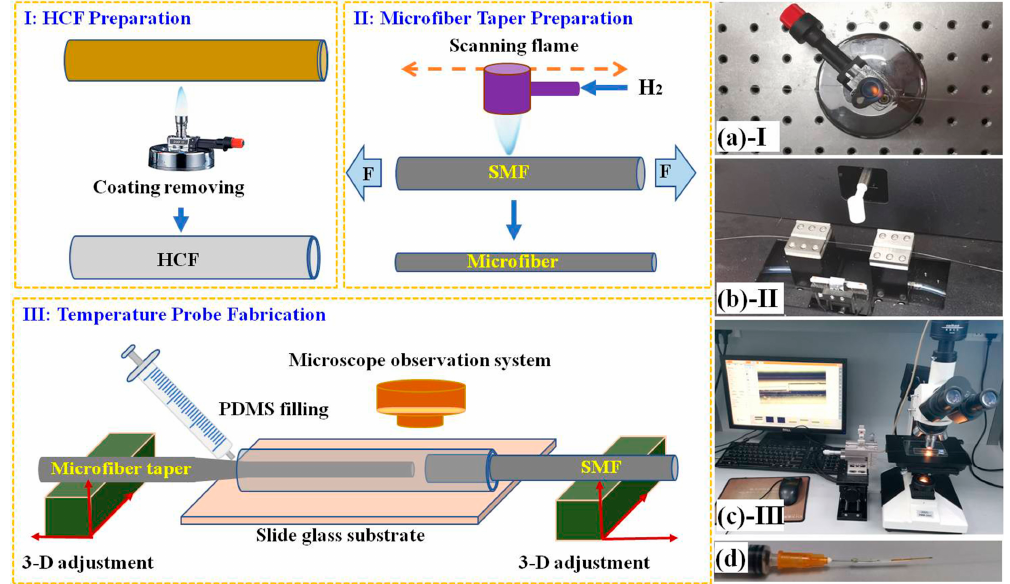
Figure 1. Fabrication process of the microfiber and PDMS based Fabry-Perot temperature probe. I: Coating layer of HCF was removed to prepare the transparent HCF (inset ( a )); II: MF taper was